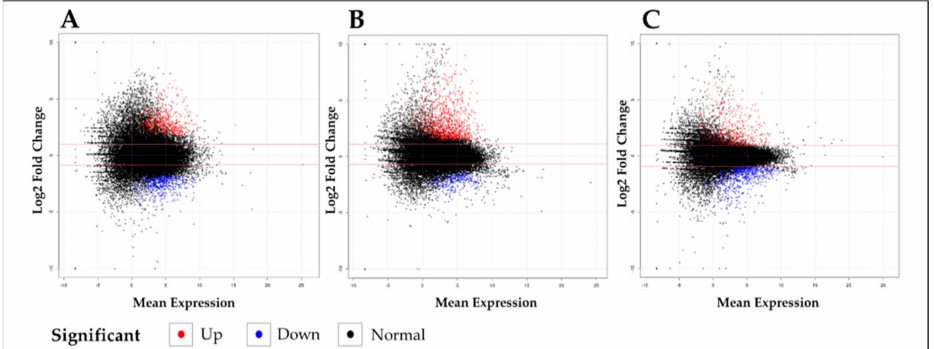
Figure 2. Scatterplots showing log 2 fold change in gene expression in rice leaf blades after exposure to UVB compared to the control, i.e., day 0 untreated samples. The graphs show the tissues sampled at ( A ) day 1, ( B ) day 3, and ( C ) day 5, respectively. The red dots indicate the transcripts higher in the treated samples (log 2 FC > 1; p -value < 0.05) and the blue dots indicate those that were lower (log 2 FC < − 1; p -value < 0.05) compared to day 0.